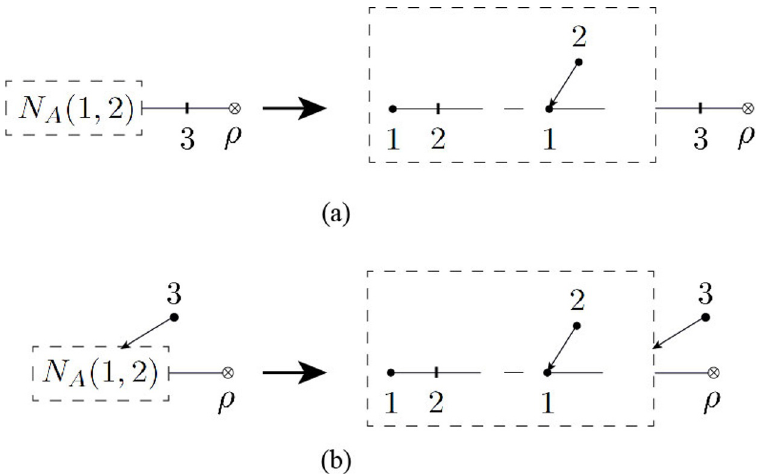
Figure 8 . Relations between the type-A graphs F ∈ G A [2 , 3] and the graphs with fewer points for the division σ = { 2 , 3 } → σ